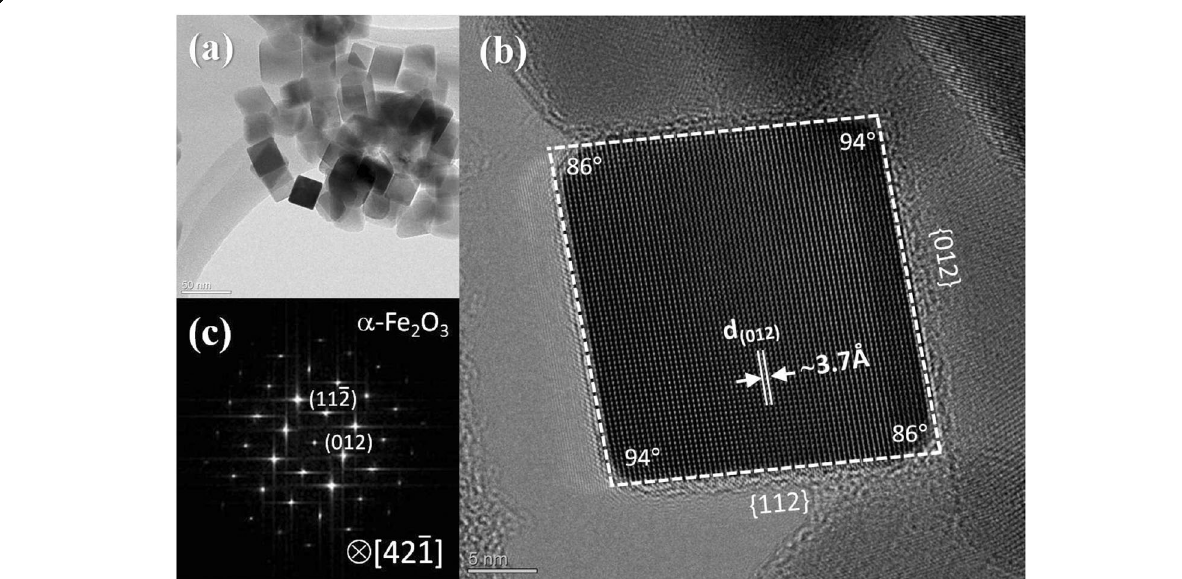
Fig. 2 a TEM image of pseudocubic-Fe 2 O 3 NPs. b High-resolution TEM image of a pseudocubic-Fe 2 O 3 NP. c The FFT pattern in b reveals an α - Fe 2 O 3 NP along its ½ 421 (cid:2)